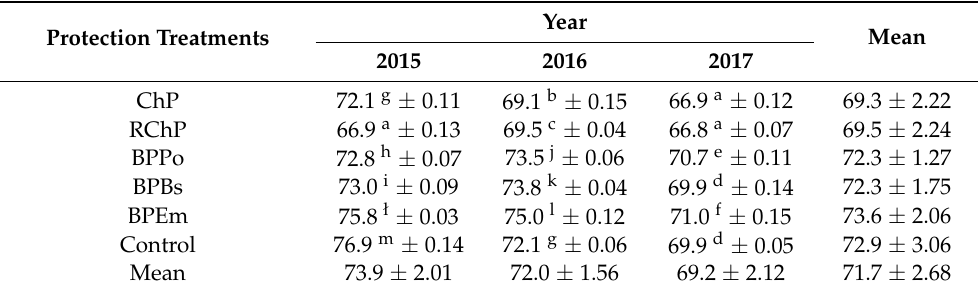
Values marked with the same letters do not differ statistically significantly, p < 0.05.